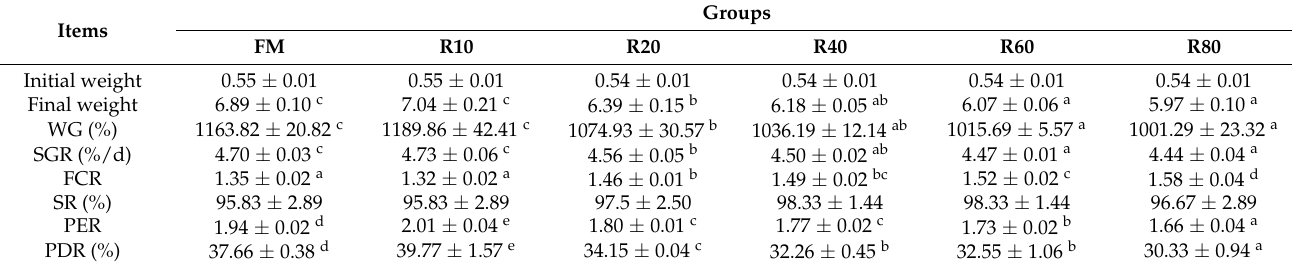
Table 4. Effects of RPM replacing fishmeal on growth for L. vannamei